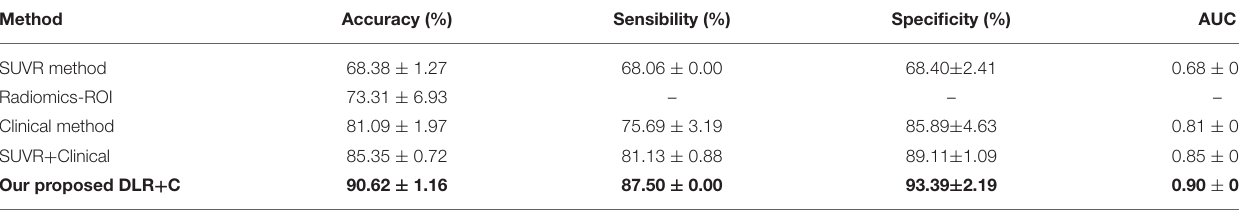
TABLE 3 | Performance of different classification approaches in mutiltasking classification.